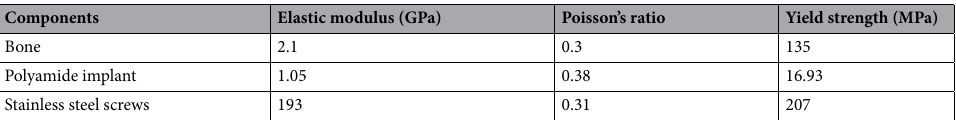
Table 1. Material properties of bone, implant and stainless steel used in the finite element analysis. Bone properties were defined lower than the original strengths to predict worse conditions for the implant in the operation. Implant properties were defined according to three-point bending test.